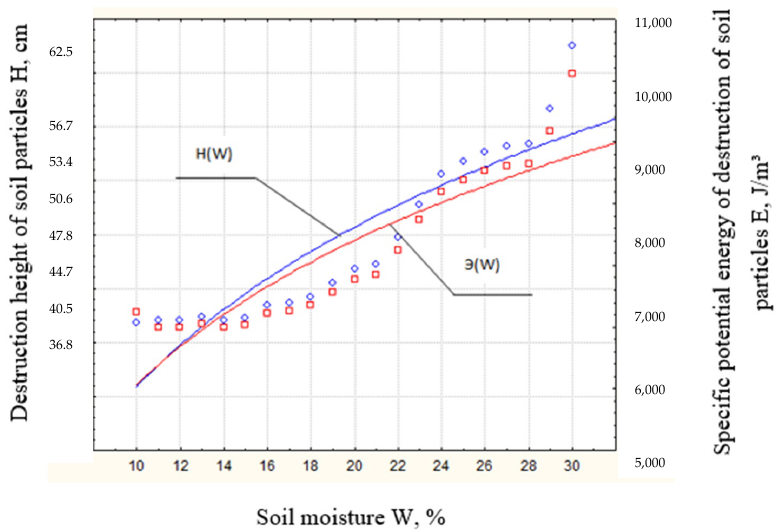
Figure 13. Dependence of the specific potential energy of the destruction of soil particles on the density, humidity, and height of fall.